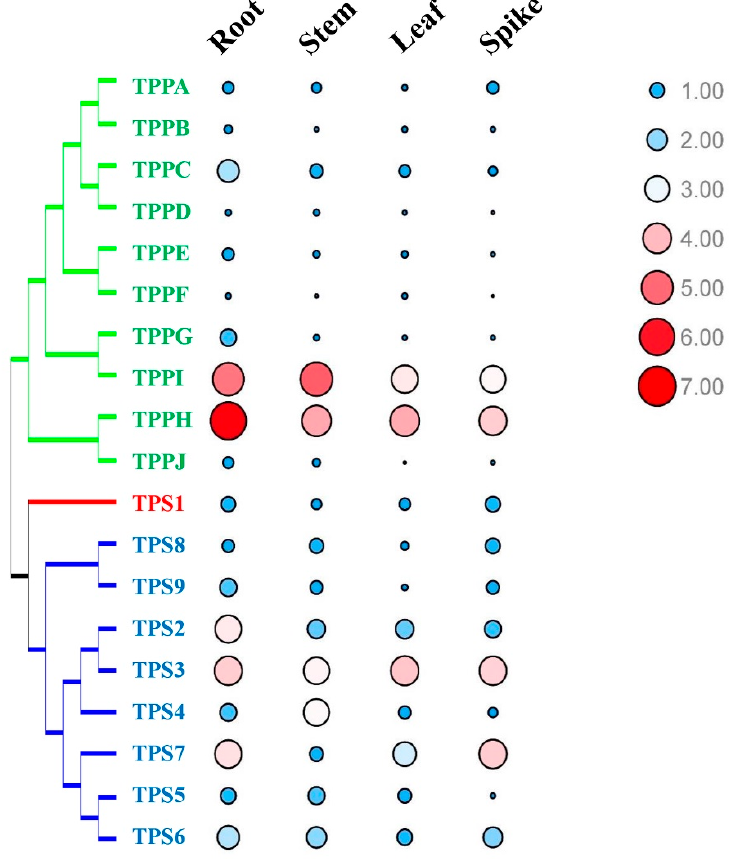
Figure 8. Expression profiles of BdTPS and BdTPP genes in four tissues. Blue color and small circle / red color and large circle that represent low / high expression, respectively.